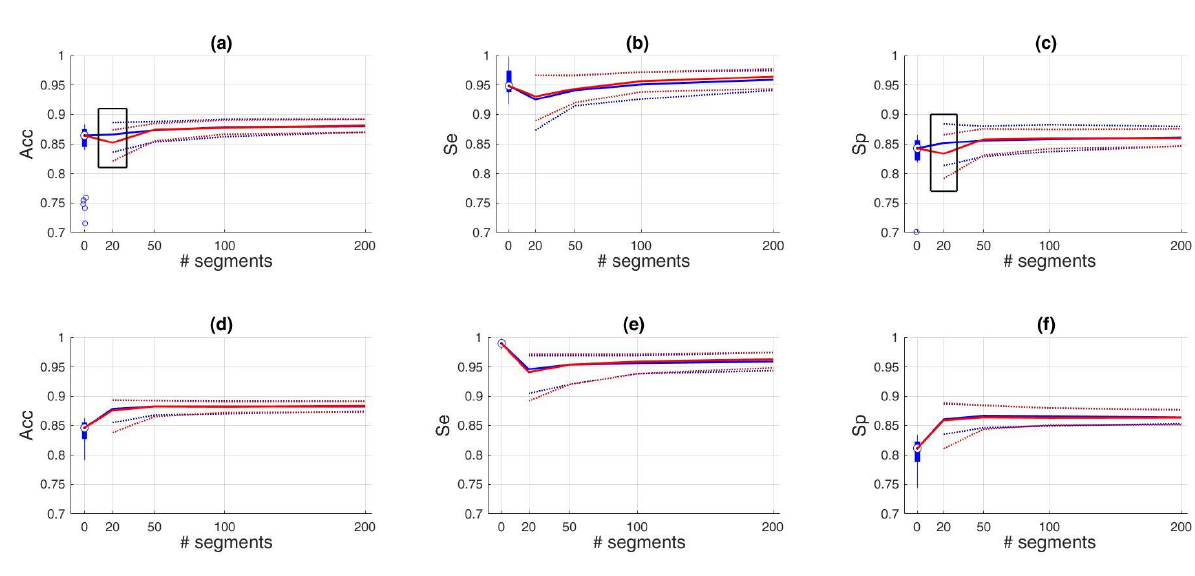
Figure 7. The effect on performance of different subset sizes and the two sampling techniques. The first row ( a – c ) corresponds to the performance of the base classifier when trained on the PSG dataset and the second row ( d – f )when trained on the HH dataset. The performance at 0 indicates the performance of the base classifier. As this is evaluated only 25 times instead of the 250 times for the transfer learning performances, we used a blue boxplot. The blue circles below the boxplot indicate outlier values. The blue line that starts in the median value at 0, corresponds to the random sampling procedure and the red line to the fixed size procedure. The dotted lines indicate the interquartile ranges. These provide insight in the variability of the classifier performance. The black boxes indicate a significantly lower performance of the active sampling strategy, compared to random sampling.